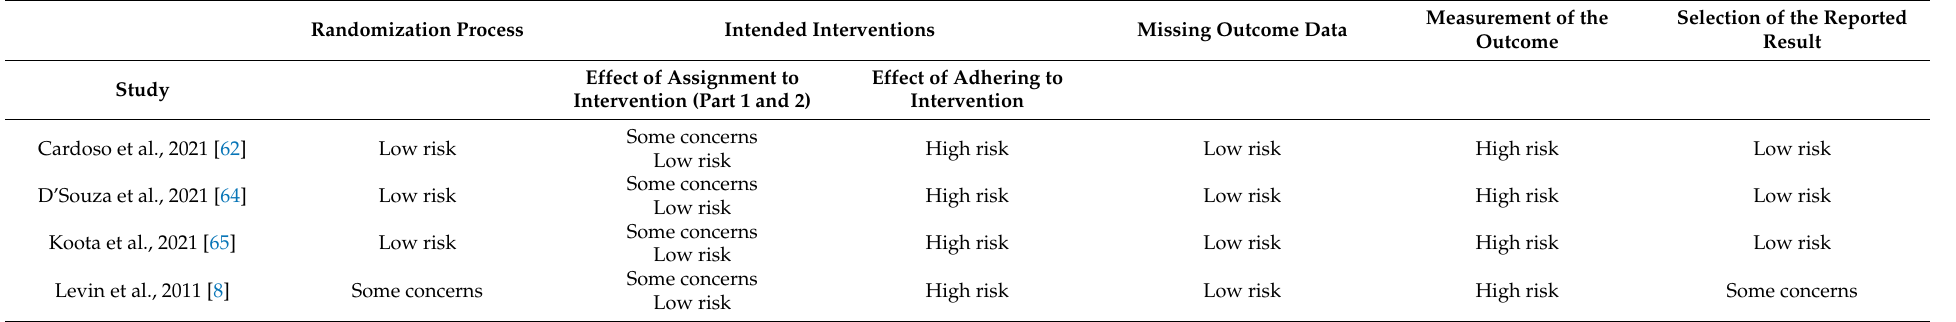
Table 4. RoB 2.0: Revised Cochrane risk of bias tool for randomized trials–randomized trial